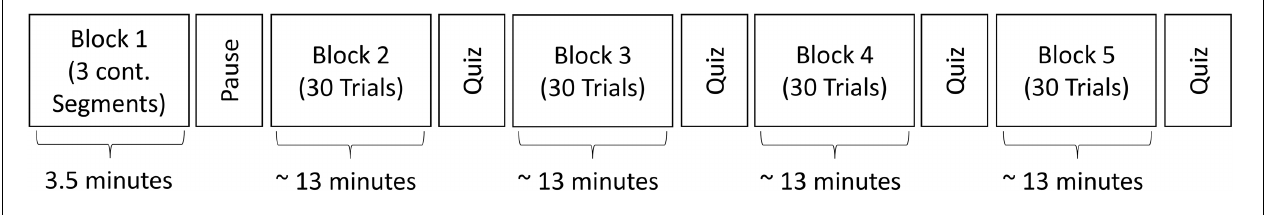
FIGURE 1 | Block design of the experimental